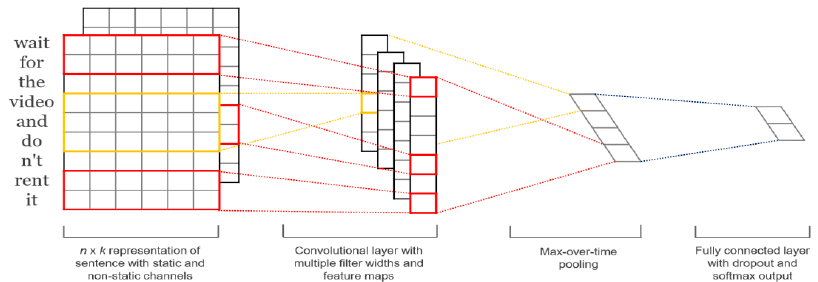
Figure 2. Convolutional neural networks (CNNs) for text classification [41].